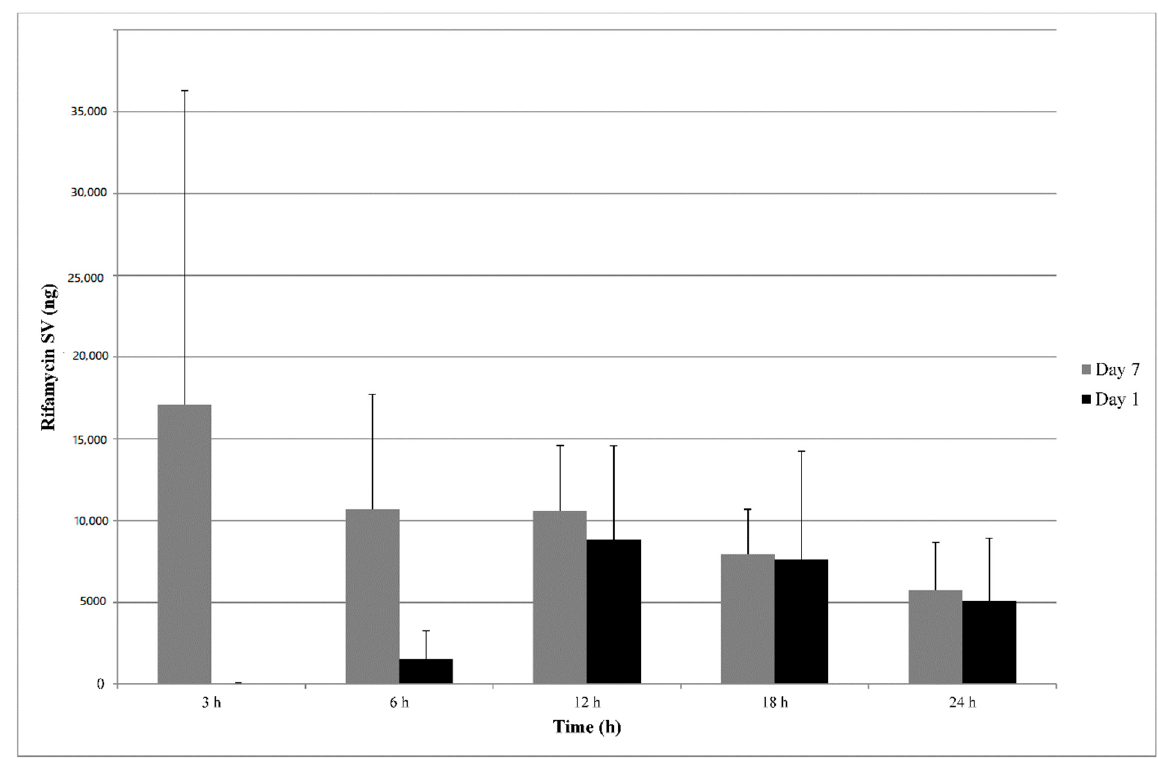
Figure 2. Mean (+SD) rifamycin SV excretion in urine (ng) vs. time profiles on Day 1 (black) and Day 7 (grey) of treatment. N = 18; Day 1: rifamycin SV concentrations on Day 1; Day 7: rifamycin SV concentrations on Day 7 . Table 6. Total amount of rifamycin SV excreted in urine calculated on Days 1 and 7 of the treat- ment; mean ± SD is reported. N=18.